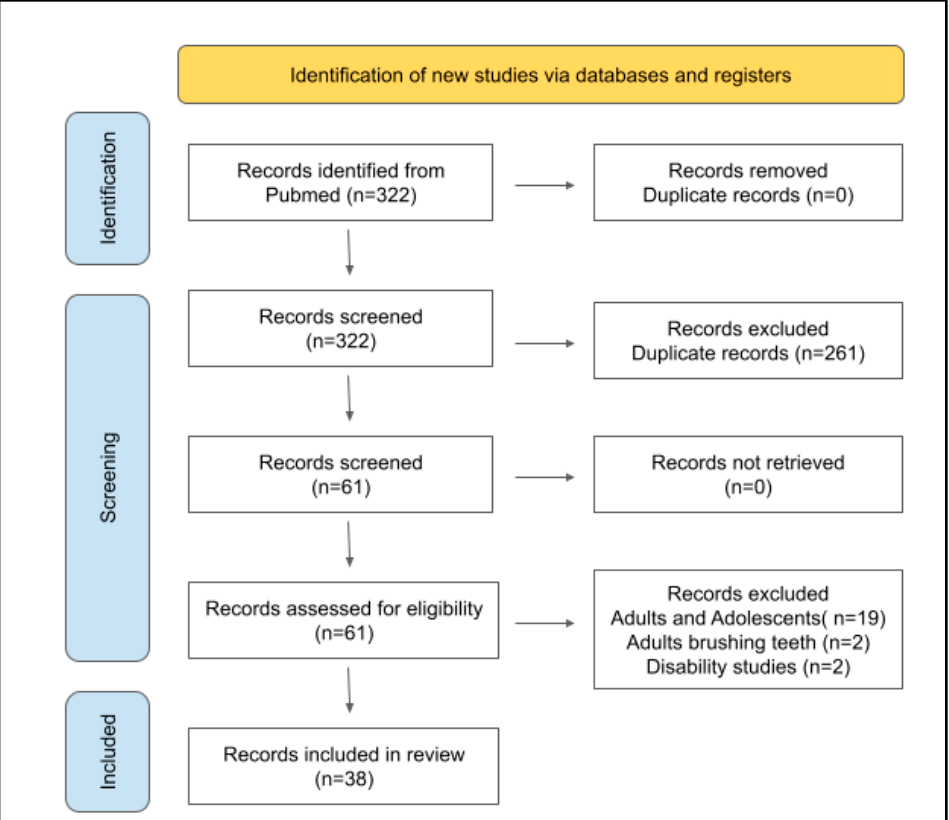
Figure 1. PRISMA protocol flow diagram of the literature review. Using the Preferred Reporting Items for Systematic Reviews and Meta-Analyses (PRISMA) protocol, the search in PubMed yielded a total of n = 322 research papers. Application of the inclusion and exclusion criteria reduced the number of articles to n = 60 for full-text retrieval. Final review of these studies and outcome measures resulted in n = 38/322 or 11.8% included in this systematic review.